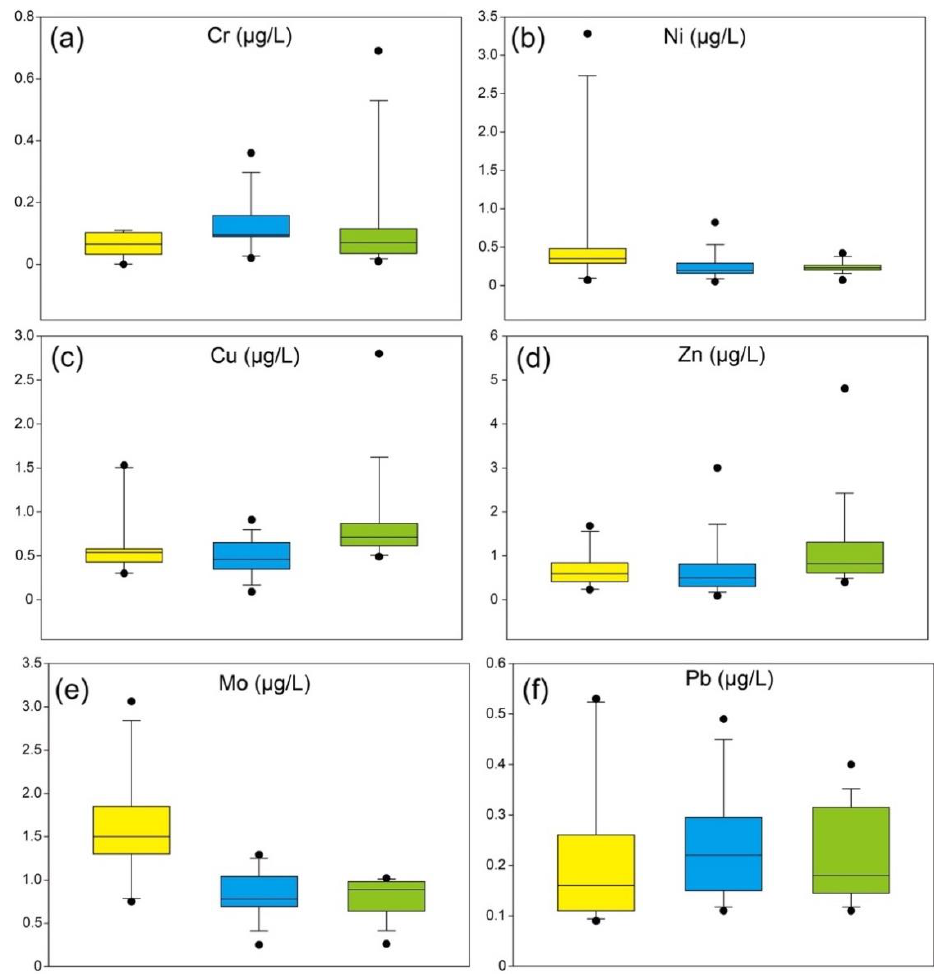
Figure 3. Boxplots of dissolved heavy metals in the Lancangjiang River: (a) Cr; (b) Ni; (c) Cu; (d) Zn; (e) Mo; (f) Pb.